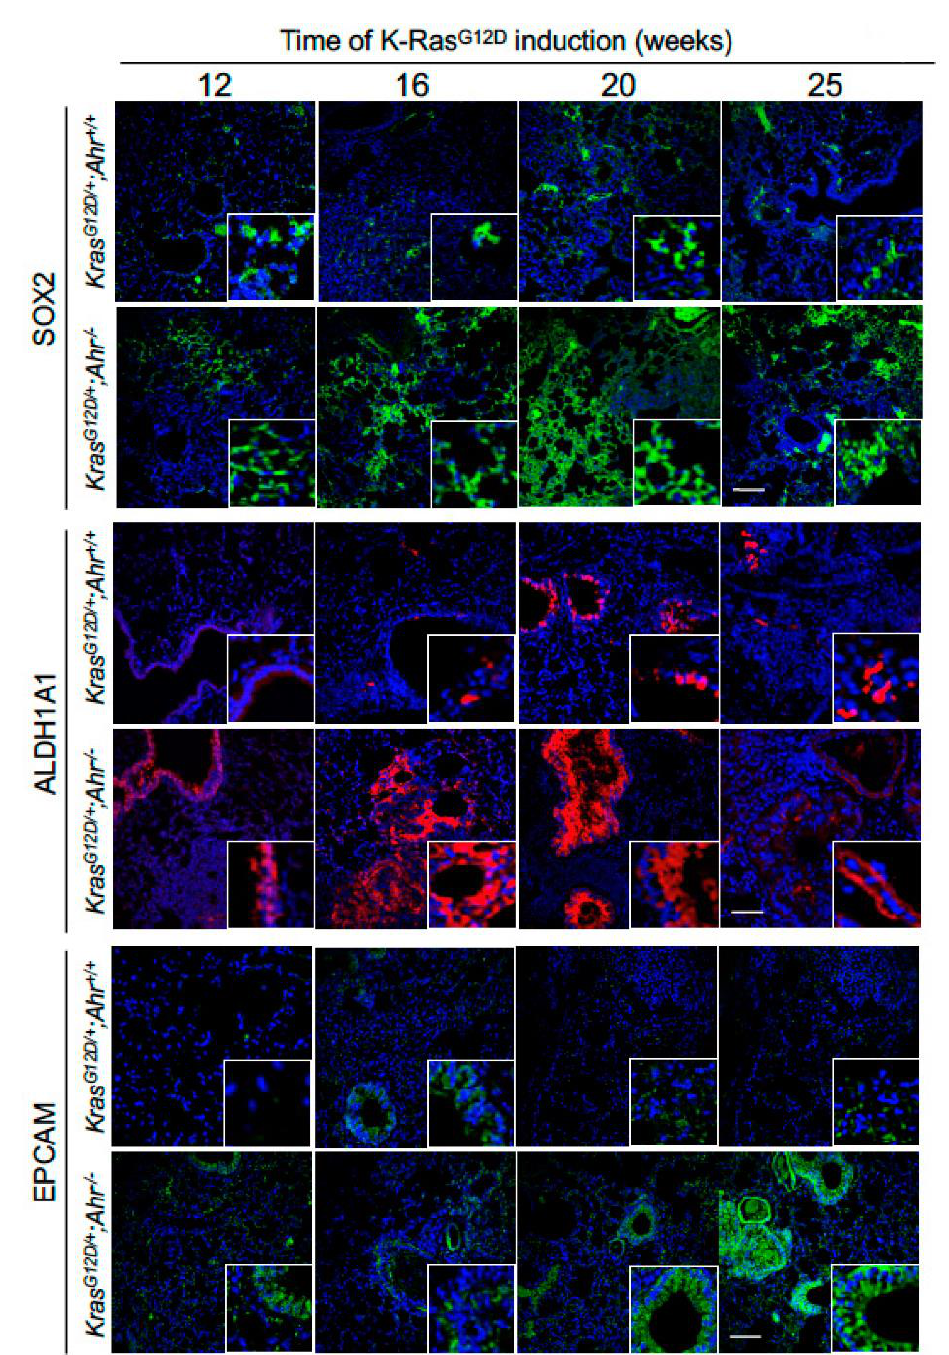
Figure 3. Lung progenitor cells expressing tumor-associated SOX2, ALDH1A1 and EPCAM markers are upregulated in K-Ras G12D/+ ; Ahr − / − mice. Lung sections from K-Ras G12D/+ ; Ahr +/+ and K-Ras G12D/+ ; Ahr − / − mice were processed and analyzed by immunofluorescence using specific antibodies for SOX2 (upper), ALDH1A1 (middle) and EPCAM (lower) for up to 25 weeks of K-Ras G12D activation. Conjugated secondary antibodies were Alexa-488 for SOX2 and EPCAM and Alexa-633 for ALDH1A1. Sections were analyzed using an Olympus FV1000 confocal microscope and the FV10 software (Olympus, Shinjuku, Japan). DAPI staining was used to label cell nuclei. Bar corresponds to 100 μm.